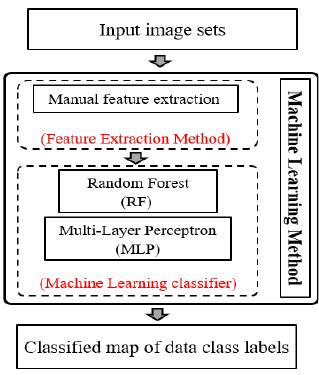
Figure 3 . Flowchart of machine learning approaches.